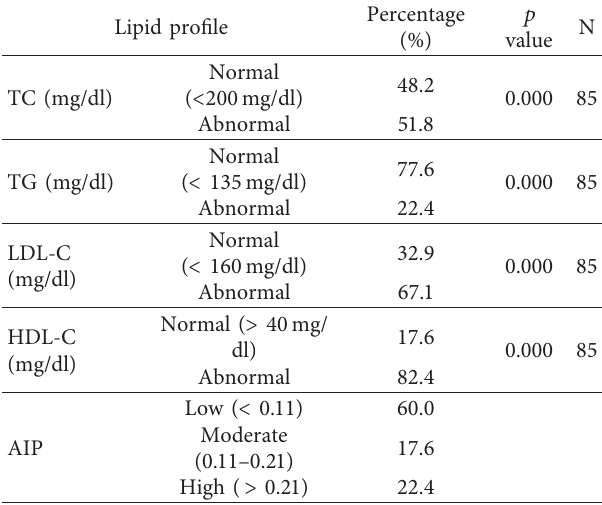
Table 2: Distribution of population according to the normal level of lipid profile and percentage of lipid